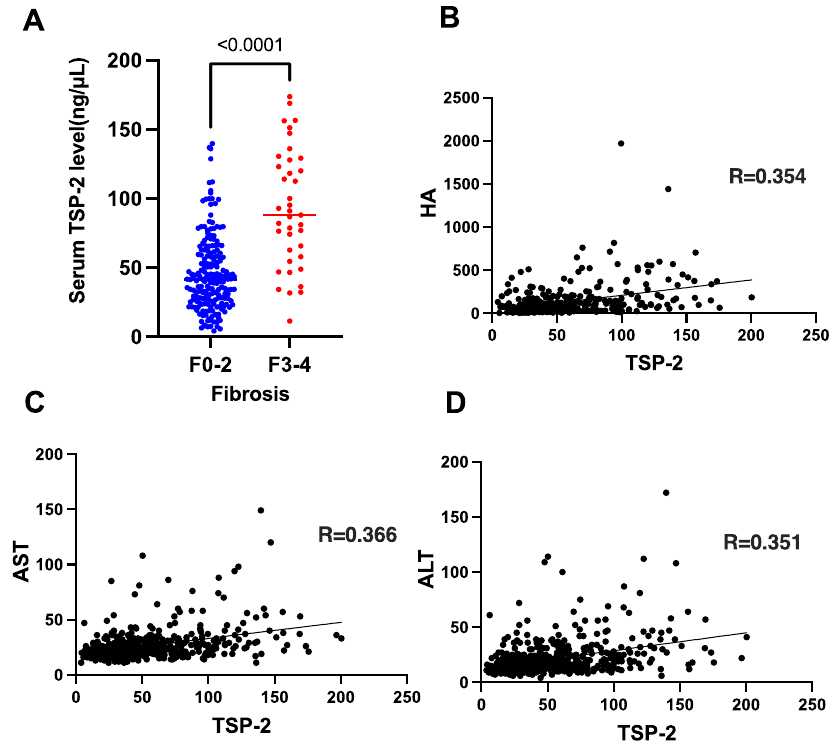
Figure 2. Serum TSP-2 levels reflect liver fibrosis and inflammation in CHC patients after HCV elimination by DAA treatment. ( A ) TSP-2 levels by fibrosis stage in the derivation cohort. ( B – D ) Correlation between TSP-2 levels and HA ( B ), AST ( C ), and ALT ( D ) in the derivation cohort.